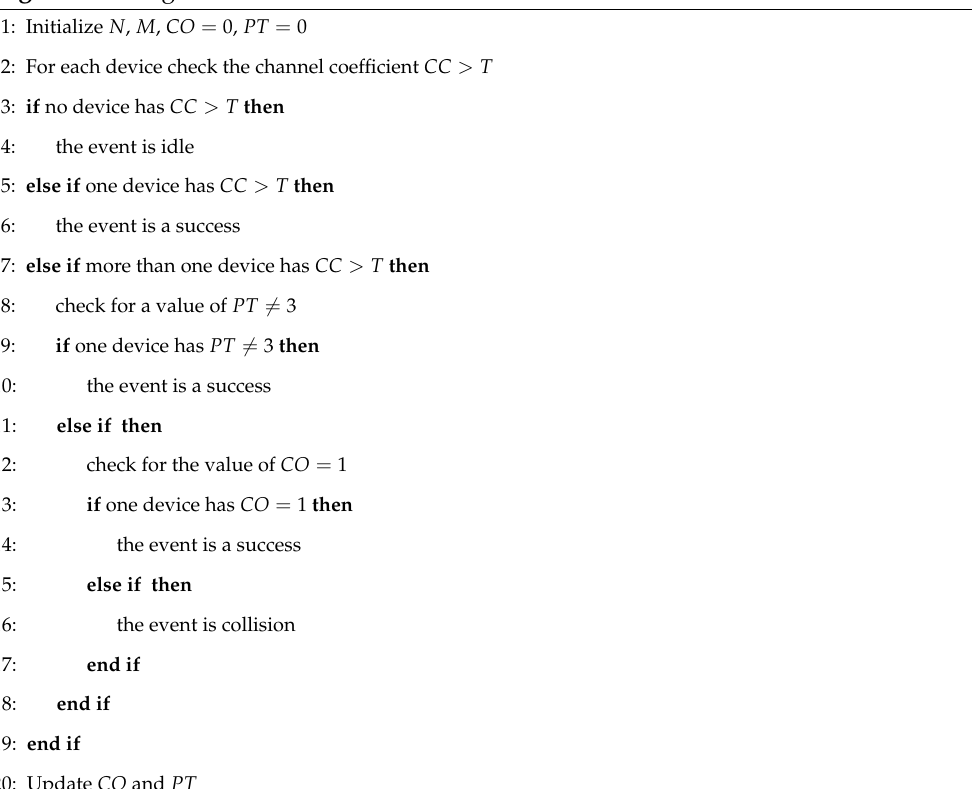
Algorithm 1 Algorithm to train the